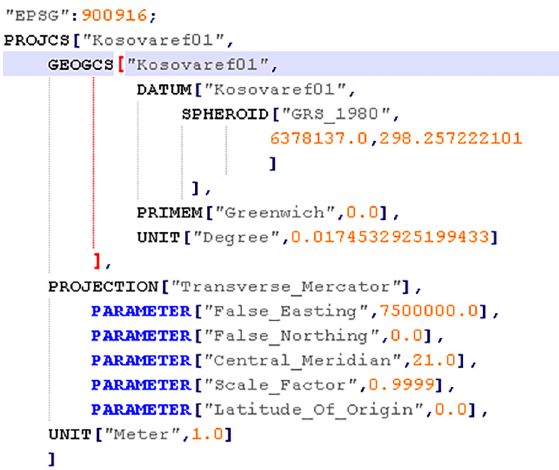
Figure 8. Determination of the Coordinate System